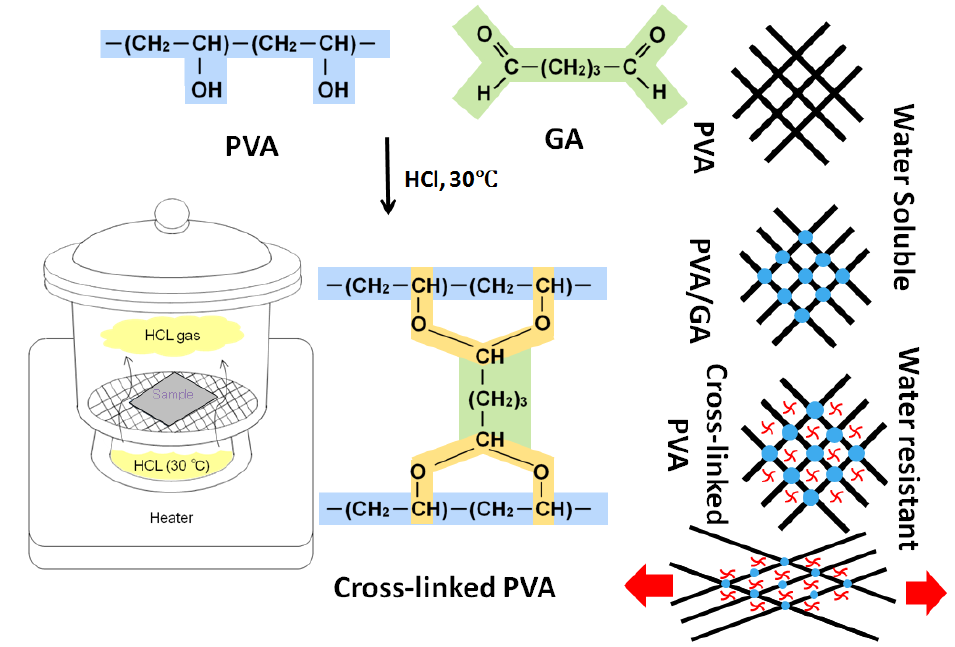
Figure 1. Illustration scheme of cross-linking nanofibers.